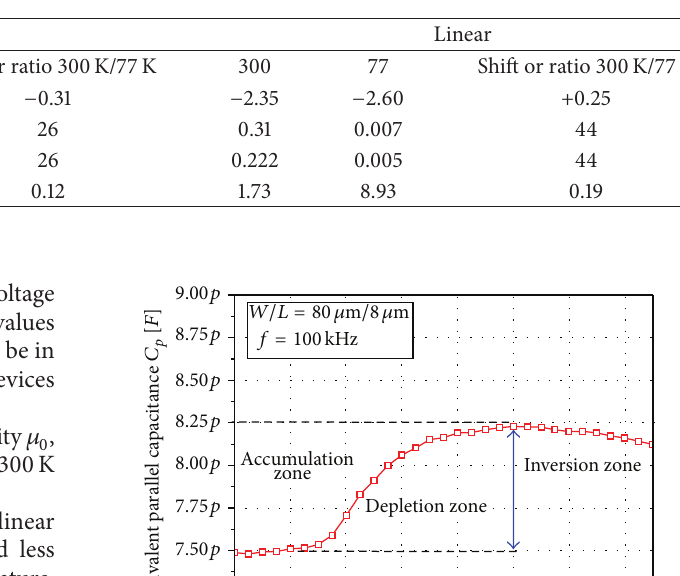
Table 4: Comparative table of threshold voltage 𝑉 𝑇 , 𝛽 , and mobility 𝜇 0 extracted from saturation and linear domain [4] at 300 K and 77K, respectively, for GRC device ( 𝑊/𝐿 = 80 𝜇 m/8 𝜇 m).